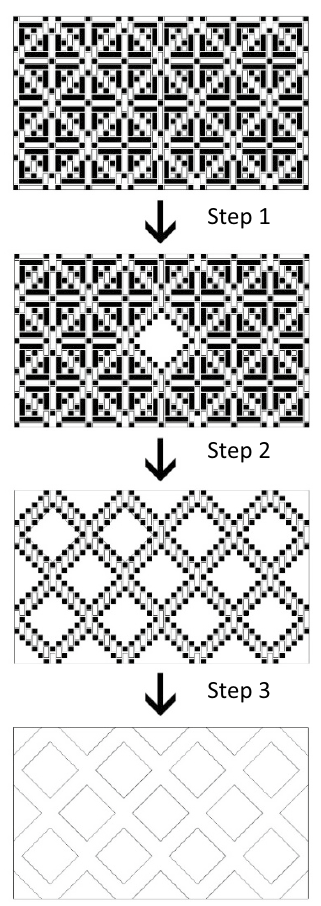
Fig. 14 Simplification steps in brick decoration for contemporary